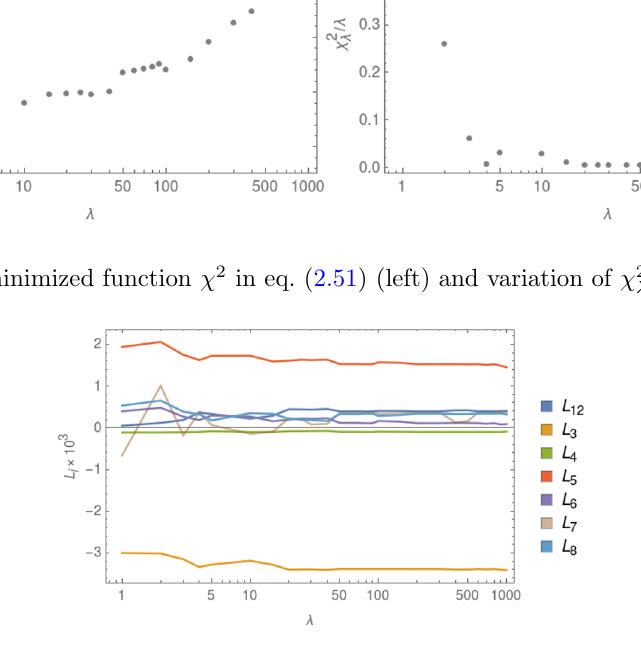
Figure 3 . Low energy constants of the IAM for HadSpec(236)+MILC data as a function of (cid:21)